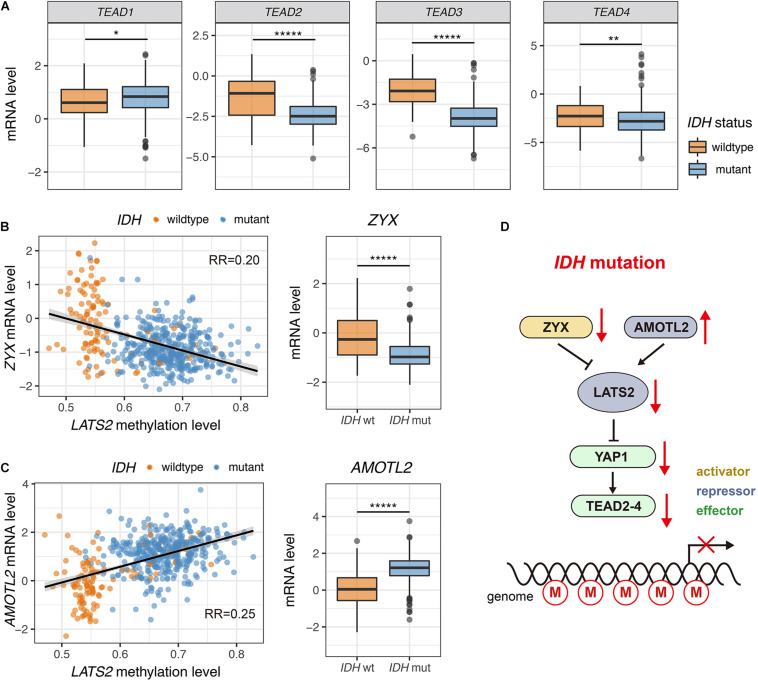
Dysregulated expression of multiple Hippo pathway genes in IDH-mutant LGG. (A) TEAD2-4 are significantly downregulated in IDH-mutant LGG while TEAD1 shows a mild upregulation. (B) Correlation between ZYX mRNA level and LATS2 methylation level (left). ZYX is significantly downregulated in IDH-mutant LGG (right). (C) Correlation between AMOTL2 mRNA level and LATS2 methylation level (left). AMOTL2 is significantly upregulated in IDH-mutant LGG (right). (D) A proposed model of ineffective LATS2 hypermethylation. Mean and standard error were presented (*p < 0.05, ** < 0.005, *****p < 0.000005, t test).